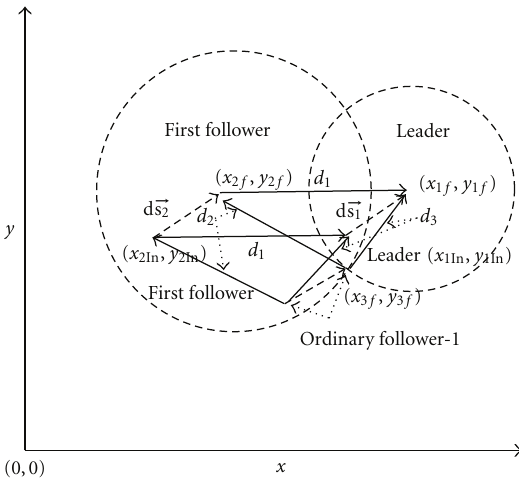
Figure 4: Motion of leader, first follower, and ordinary follower-1 for a very small duration of